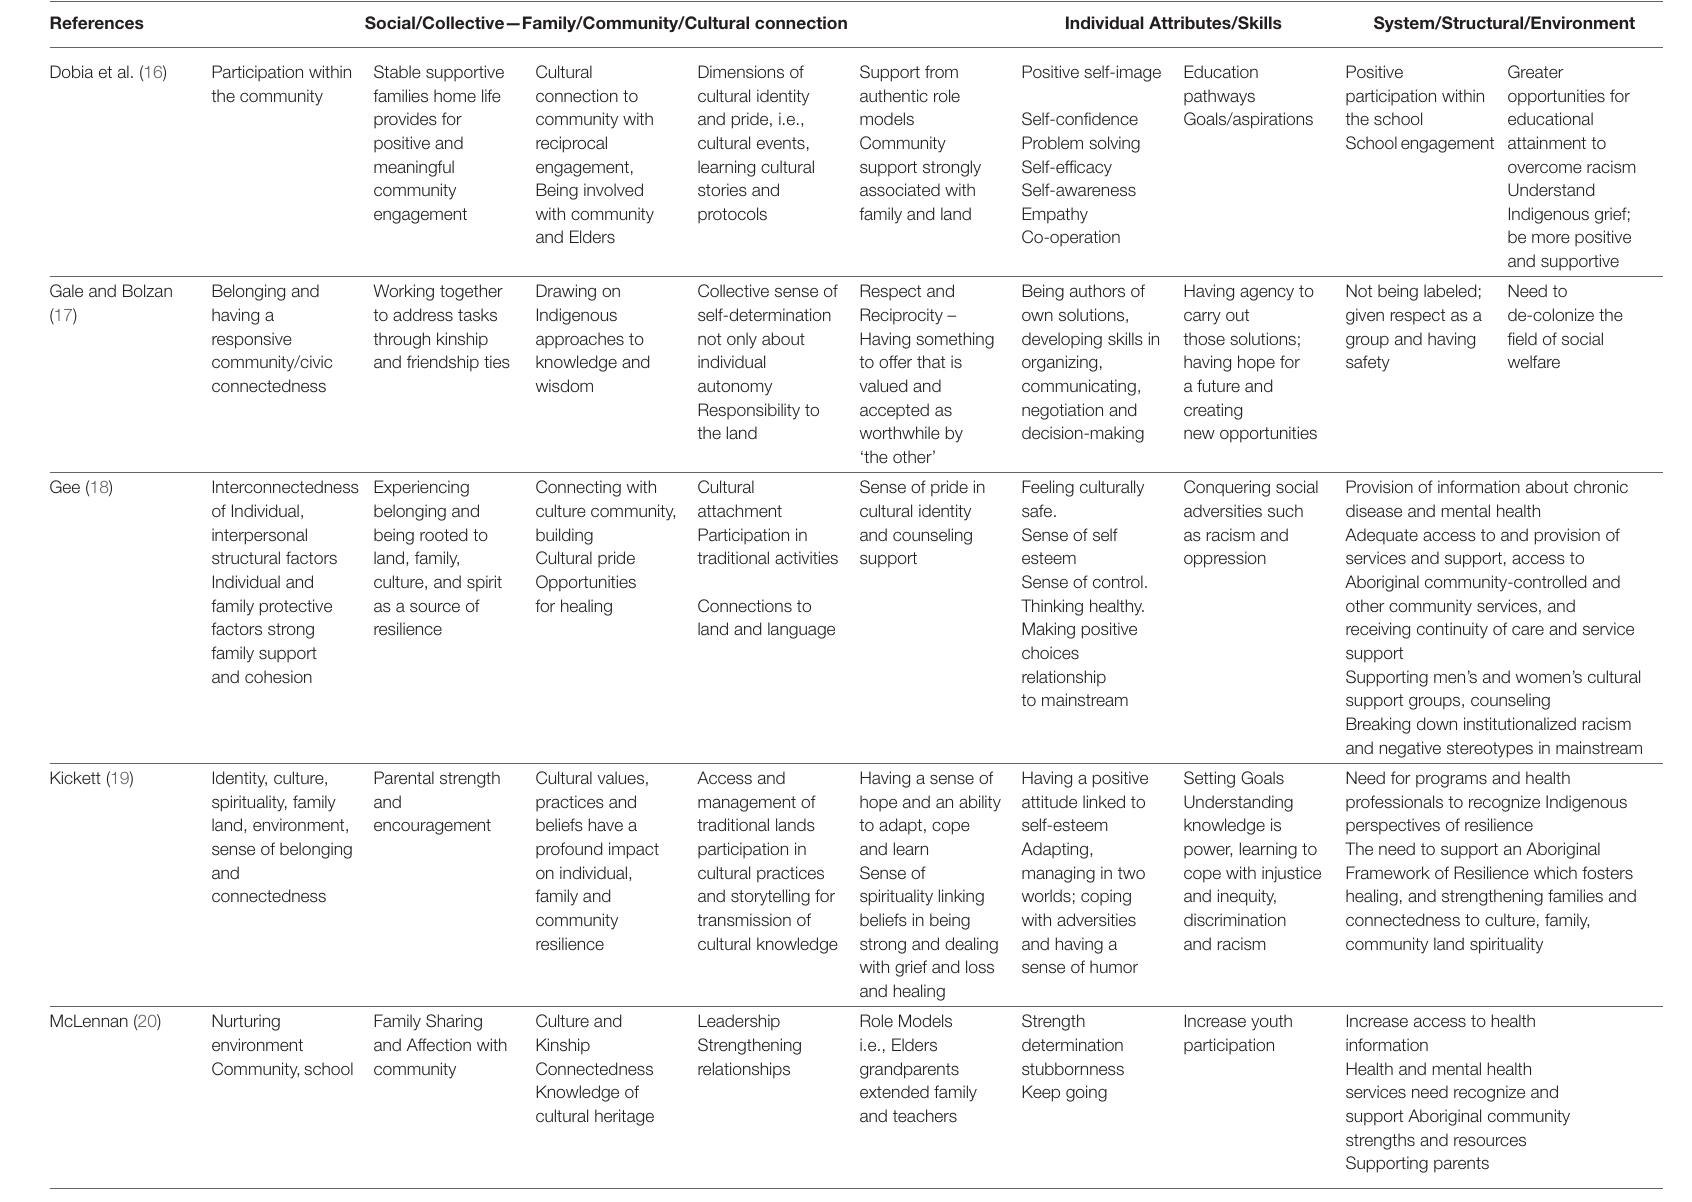
TABLE 4 | Protective factors of aboriginal